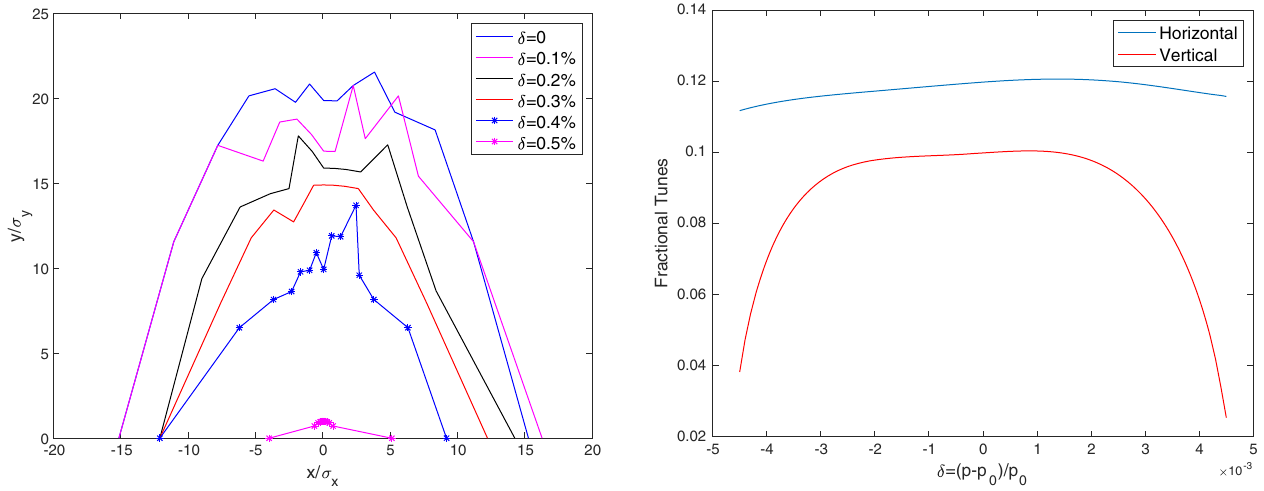
FIG. 4. Dynamic aperture (left) and chromatic tune (right) in the lattice with two global families of